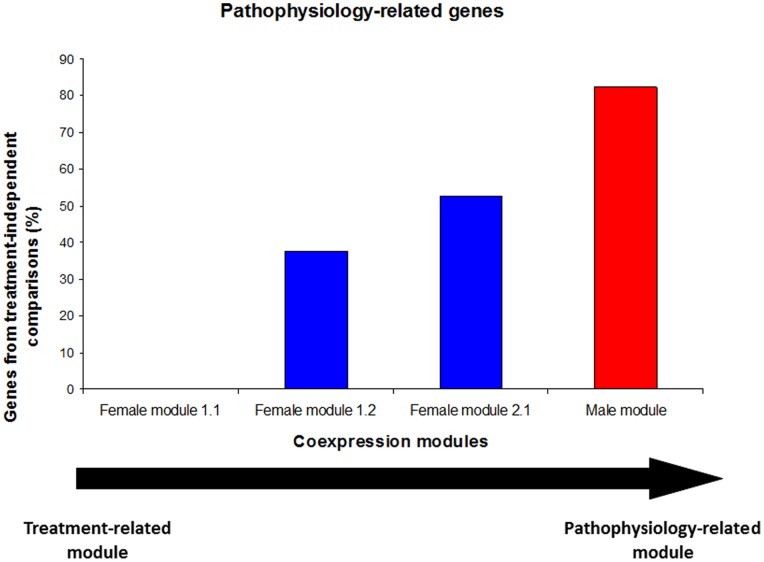
Percentage of genes obtained from “treatment-independent” comparisons for the main coexpression modules.The percentage of the genes that appeared in the comparisons made with the samples from the patients with the same treatment in remission and relapse and from patients with no treatment at all is visualized and used as a measure for how truly a module reflects the underlying pathophysiology.